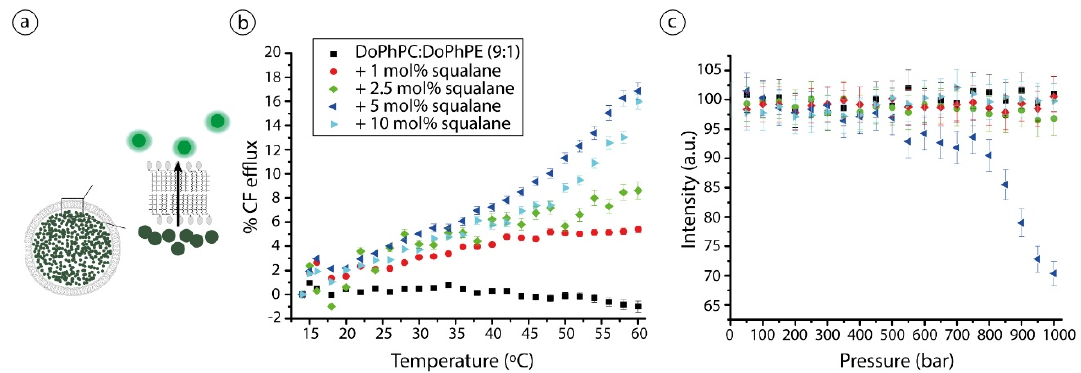
Figure 2. ( a ) Schematic representation of the CF efflux method, inside liposomes. CF is self-quenched but the fluorescence intensity emerges once it is released from liposomes due to a concentration decrease. The size of probes is not at scale. ( b ) The % CF efflux as a function of temperature and ( c ) CF normalized intensity versus high hydrostatic pressure applied on liposomes composed of DoPhPC:DoPhPE (9:1) in absence (black squares) or in presence of different squalane percentages: 1 mol% (red spheres), 2.5 mol% (green diamonds), 5 mol% (blue left triangles) and 10 mol% (cyan left triangles). Data represent triplicate (temperature) or duplicate (high hydrostatic pressure) measurements. No data points were excluded from the analyses.